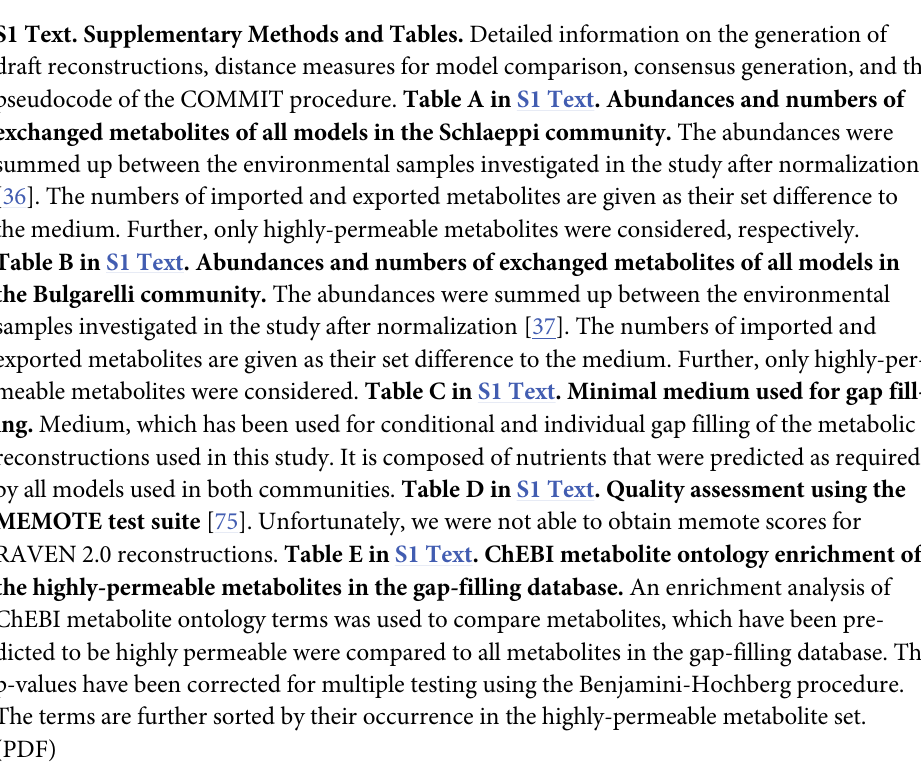
S9 Fig. Prediction quality of different kNN regression models. The root mean square error (RMSE) and adjusted R-squared value were compared between kNN regressions with different values for k . The utilized regression model with k = 1 is highlighted in light grey.